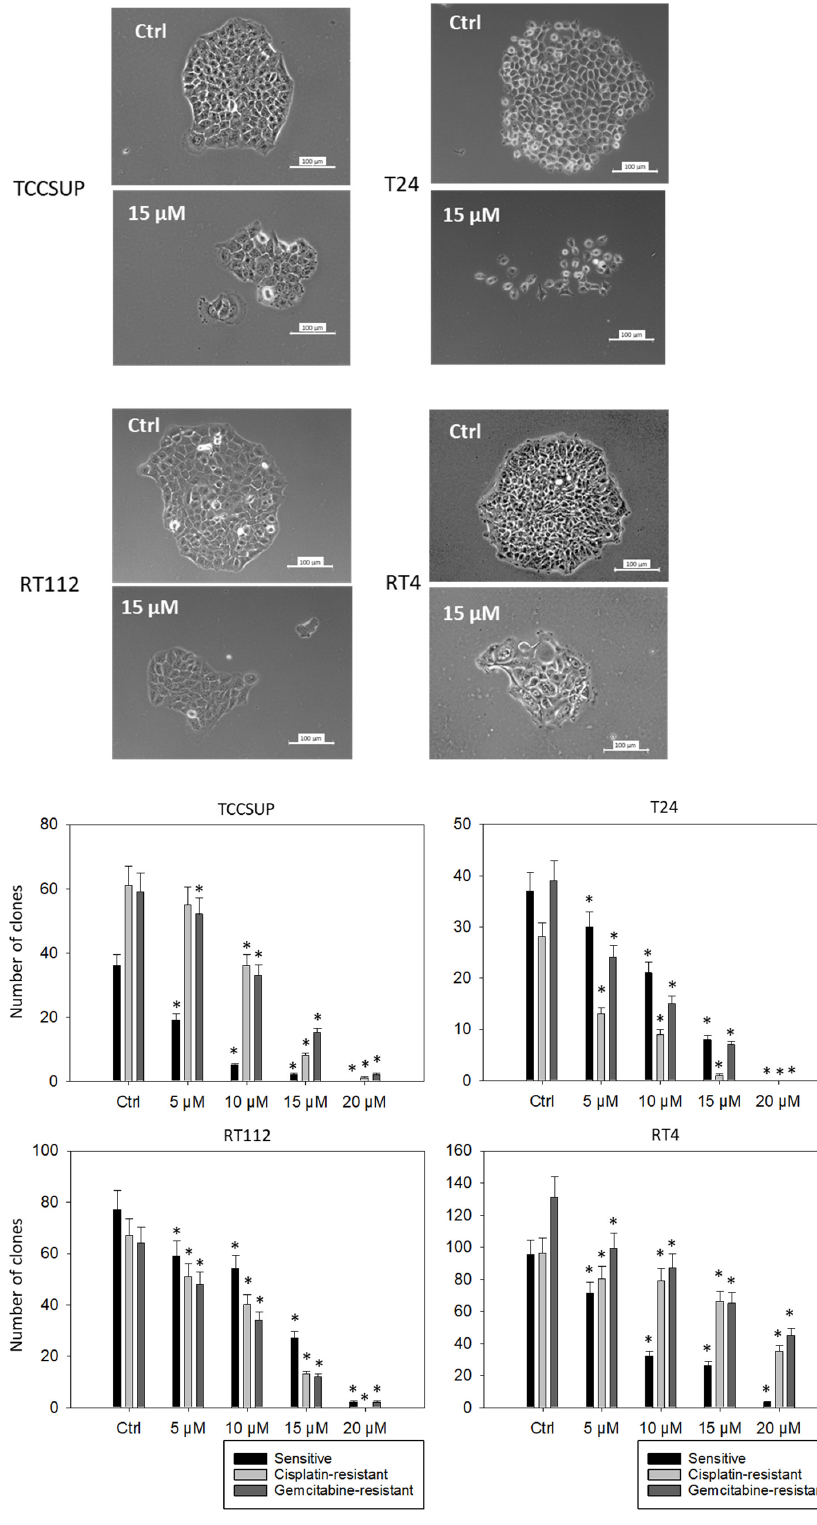
Figure 5. Influence of SFN on the clone formation of sensitive TCCSUP, T24, RT112, and RT4 cells. Bar diagrams indicate clone counts in the presence of 5–20 µM SFN. Pictures of single tumor clones are related to the treatment of sensitive cells with 15 µM SFN. Controls (Ctrl) were without SFN, n = 3. * indicates a significant difference compared to untreated controls.